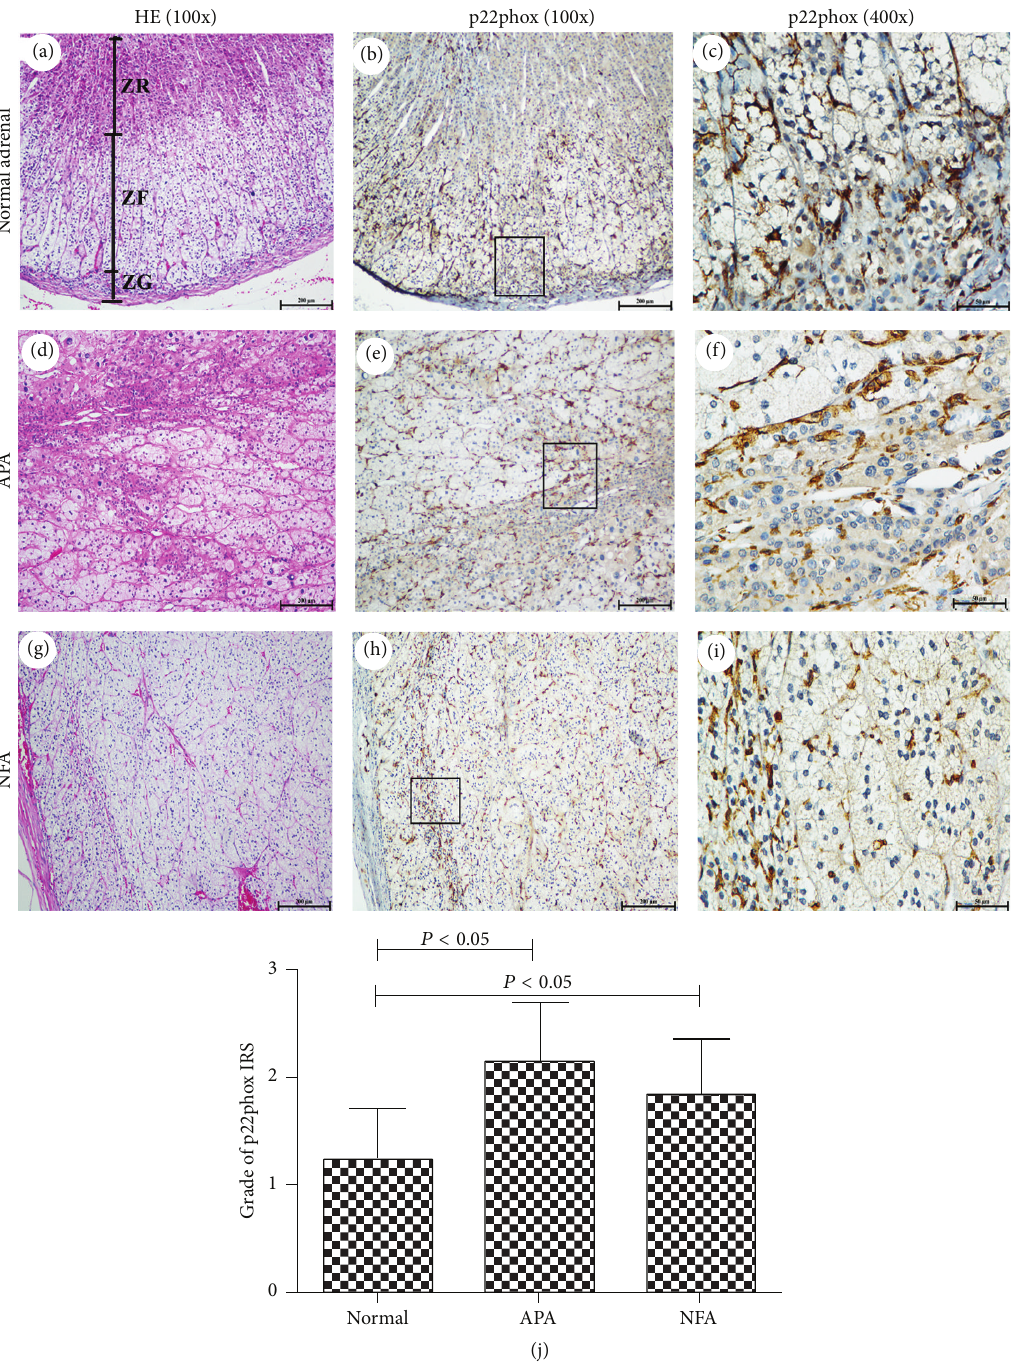
Figure 3: Pathological and immunohistochemical analyses of p22phox in normal adrenocortical tissue, APA, and NFA. (a–i) p22phox presents a gradient of expression in the entire adrenal cortex (100x), and its localization was restricted to the cell membrane (400x). (j) Graphical illustration of the statistical distributions of p22phox in normal adrenocortical tissue, APA, and NFA. The p22phox IRS was higher in APA compared to that in normal adrenal